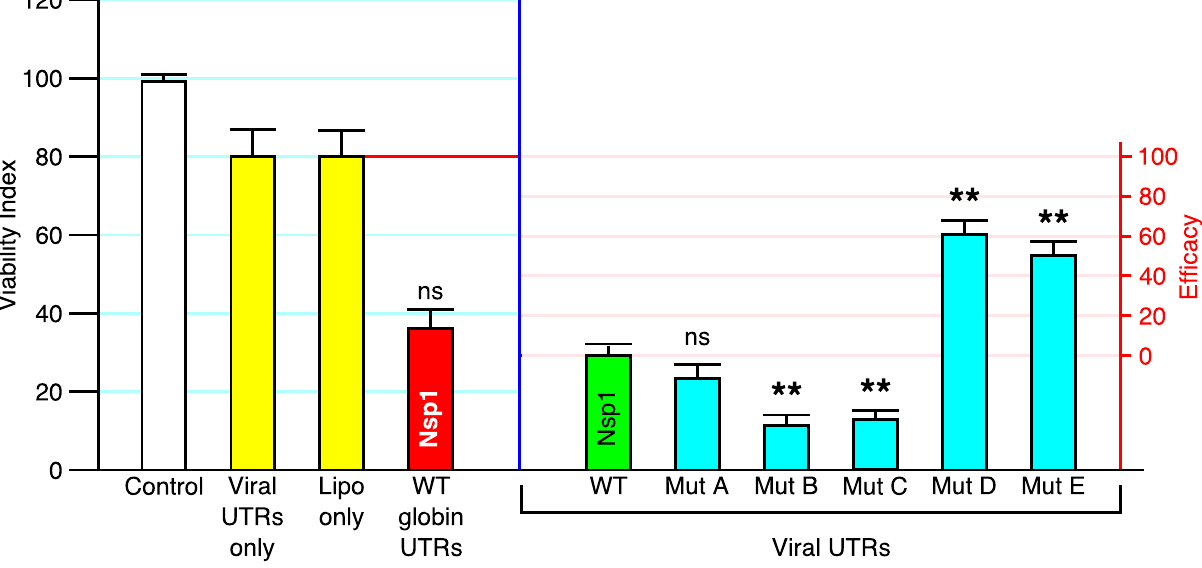
Figure 3. Measurement of efficacy and relationship to Nsp1 mutants. The Viability Index was determined for H1299 cells treated under various control conditions: no transfection (Control), transfected with RNA containing only viral 5 ′ and 3 ′ UTR and no coding sequence (Viral UTRs only), or transfected with no RNA (Lipo only). Nsp1 mRNA was also transfected into H1299 cells in different contexts: wild-type Nsp1 flanked by the 5 ′ UTR and 3 ′ UTR corresponding to that of human alpha-globin mRNA (WT globin UTRs), or flanked by the viral UTRs corresponding to that of SARS-CoV-2 (WT Viral UTRs). All point mutations of Nsp1 (A through E, corresponding to the point mutations described in Fig. 2) were expressed as coding regions flanked by Viral UTRs. Efficacy is defined by a different scale as indicated, and represents the degree to which wild-type Nsp1 toxicity is reversed compared to H1299 cells incubated under the same conditions of transfection.